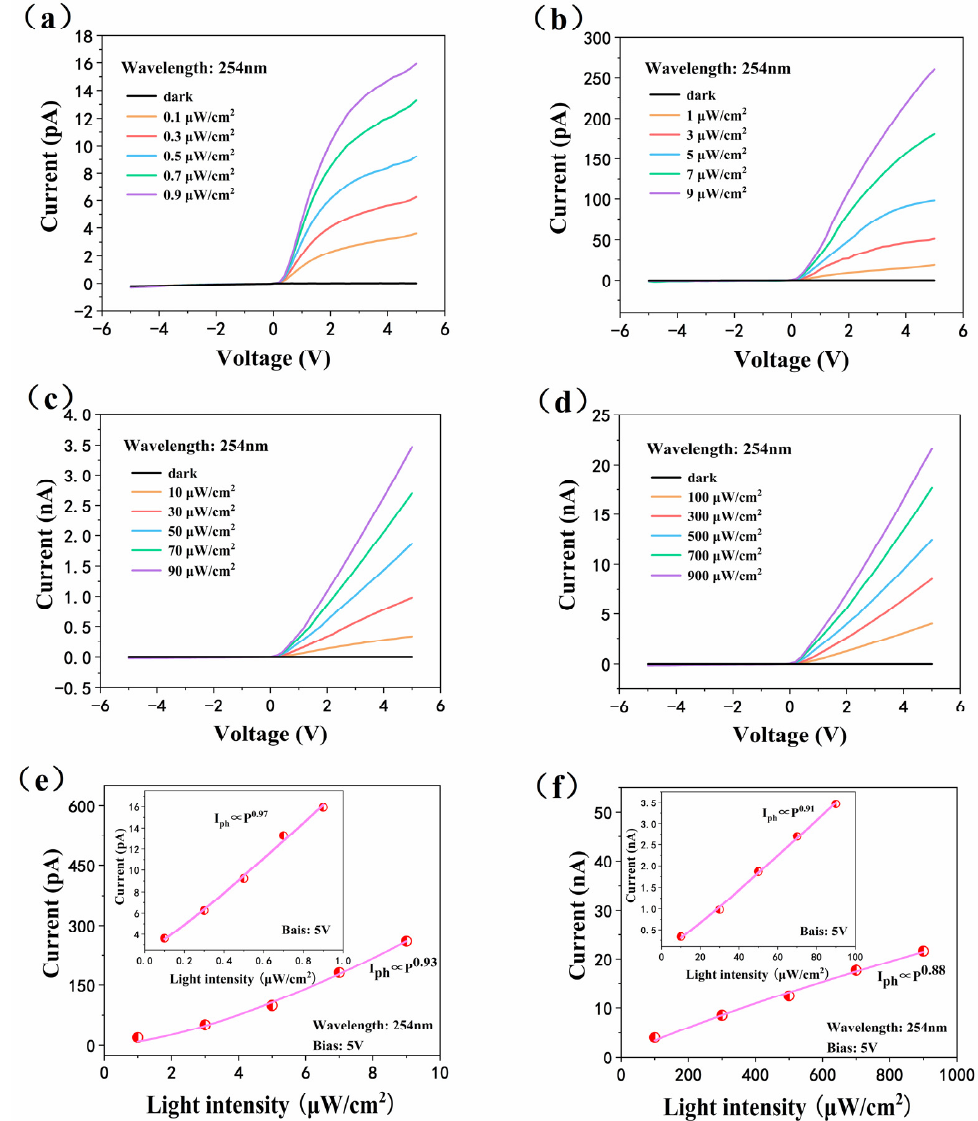
Figure 3. The I-V curves of the heterojunction device with various light powers: ( a ) 0.1–0.9 μ W/cm 2 , ( b ) 1–9 μ W/cm 2 , ( c ) 10–90 μ W/cm 2 , and ( d )100–900 μ W/cm 2 . The photocurrents of heterojunction device with various light powers under 5 V: ( e ) 1–9 μ W/cm 2 (insert was 0.1–0.9 μ W/cm 2 ) and ( f ) 100–900 μ W/cm 2 (insert was 10–90 μ W/cm 2 ).